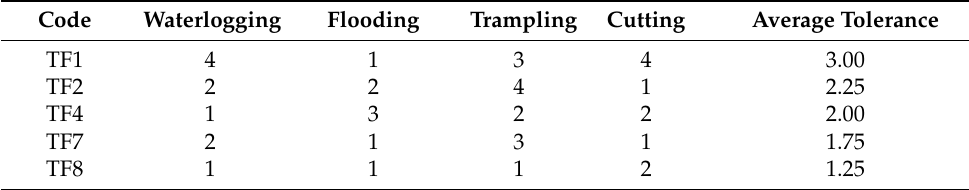
Table 4. Relative comparison of overall tolerance of Trifolium fragiferum accessions to different abiotic factors.